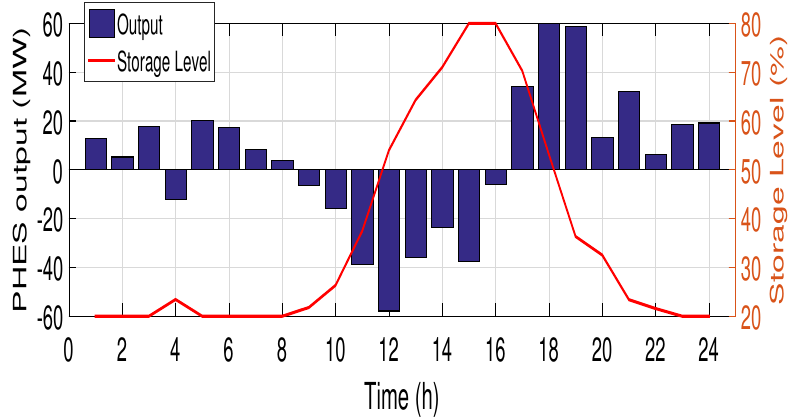
Figure 14. PHS output and storage